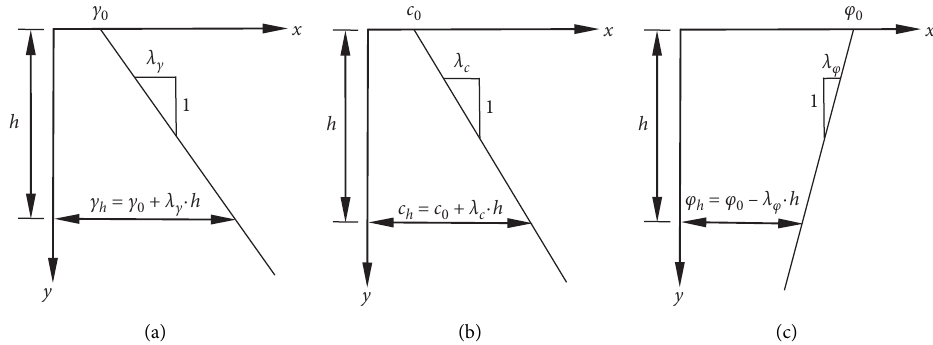
Figure 1: Mechanical parameters varying along the depth below the slope.